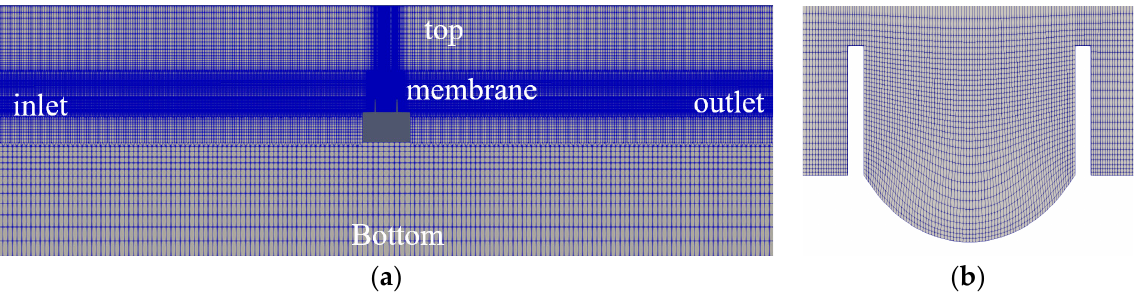
Figure 3. CFD mesh ( a ) of whole wave tank and ( b ) inside the collector with a deformed mem- brane.